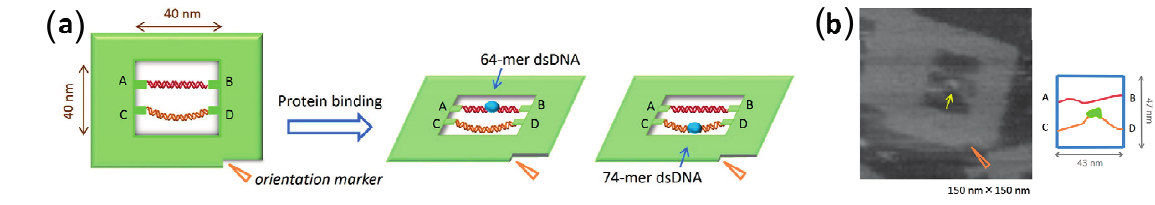
Figure 8. ( a ) Scheme of the DNA origami frame with a tensed 64-mer (red) and a relaxed 74-mer DNA substrate (orange) for Sox2 binding; ( b ) AFM image of Sox2 bound to the relaxed substrate strand ( left ) and representation of the kinked geometry of the substrate strand obtained from the AFM image ( right ). Adapted with permission from Ref. [49]. Copyright 2014 American Chemical